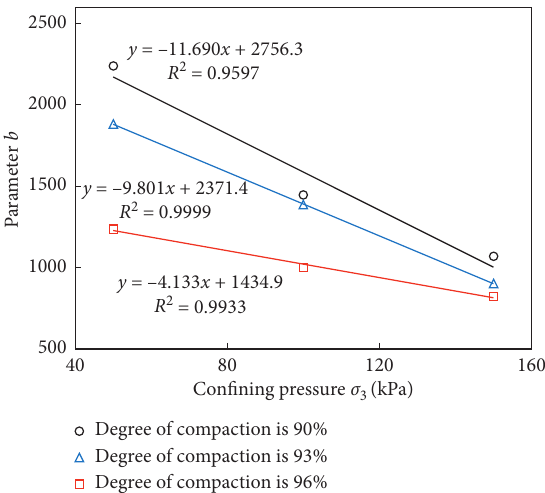
Figure 7: Relationship between the parameter b and the confining pressure σ 3